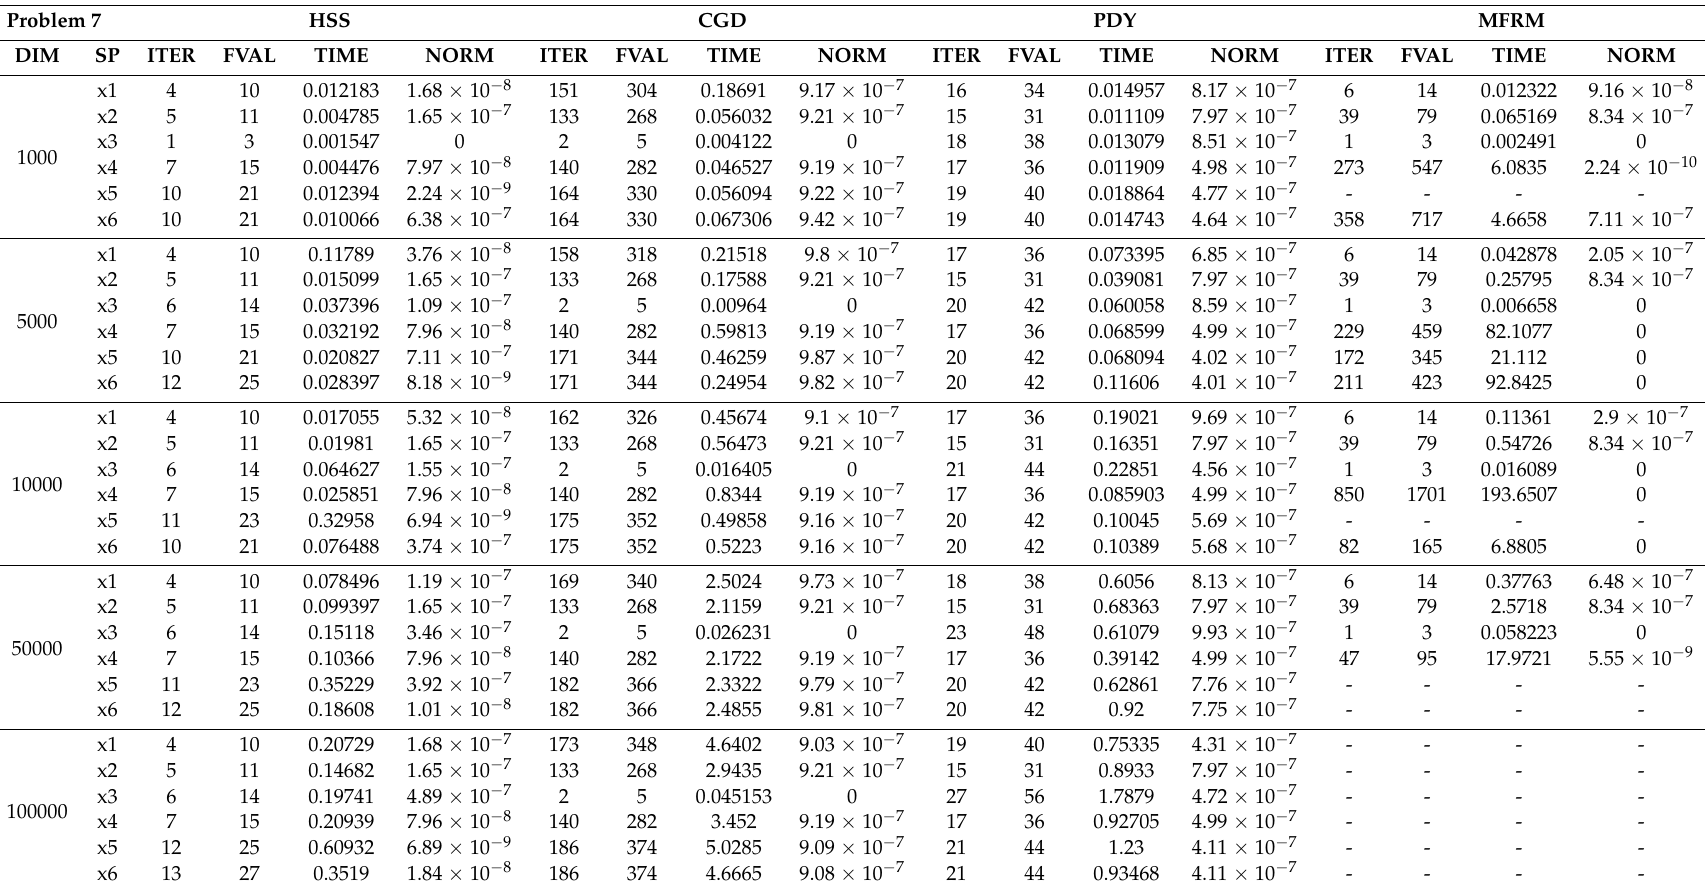
Table 7. Test results obtained by the four solvers for Problem